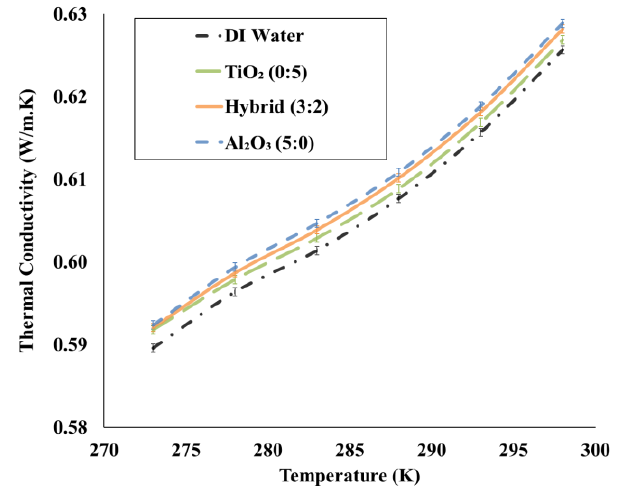
Figure 6. Thermal conductivity versus temperature for different fluids.